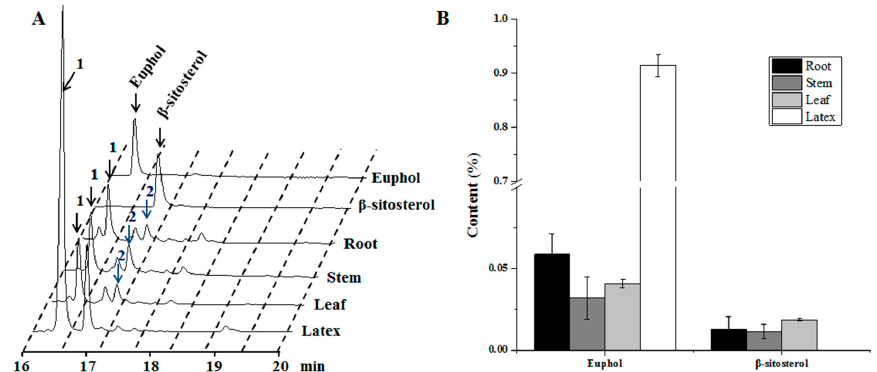
Figure 1. Phytochemical analysis of different Euphorbia tirucalli tissues. ( A ) GC-traces of the extracts from root, stem, leaf, and latex samples. In the figure: peak1, euphol; peak 2, β -sitosterol; ( B ) The concentrations of euphol and β -sitosterol in different fresh tissues. GC: